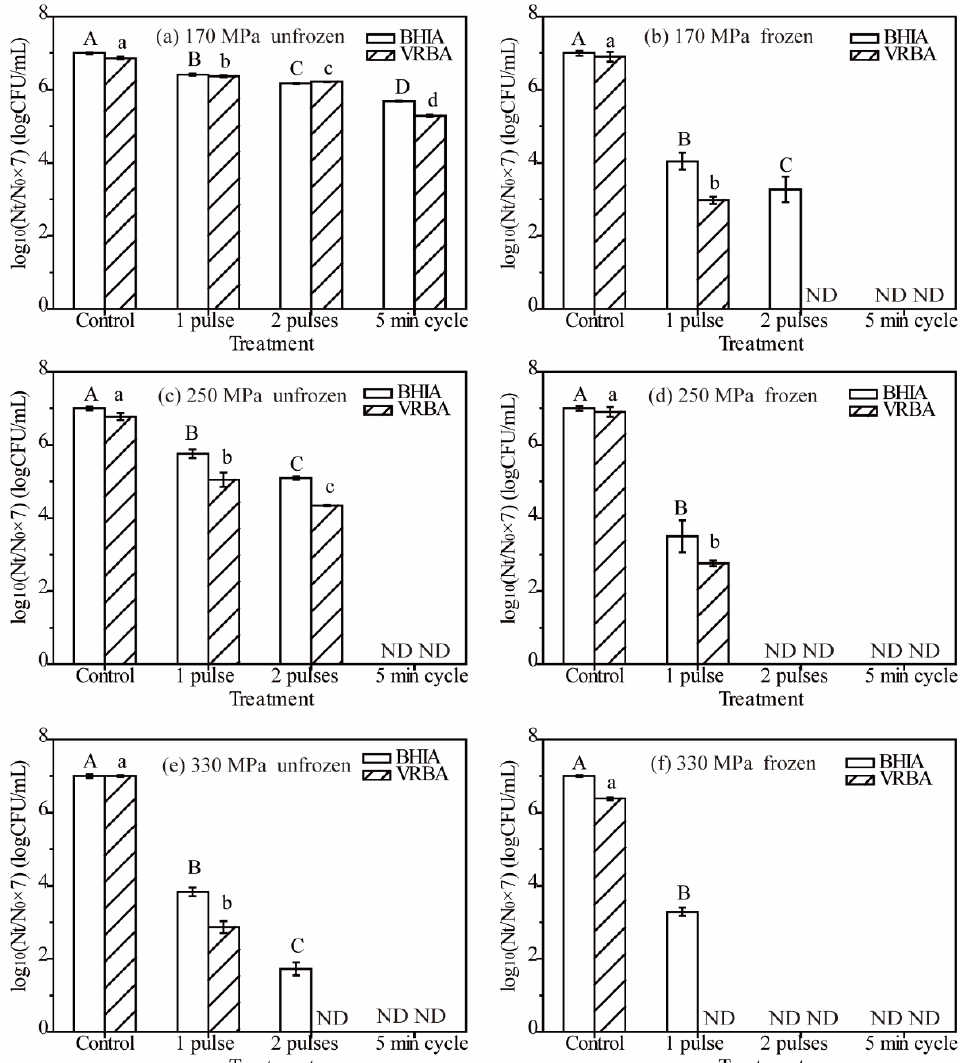
Figure 3. The E. coli survivors in unfrozen and frozen Chinese bayberry juice after different HP treatments (170 MPa (( a ) unfrozen, ( b ) frozen), 250 MPa (( c ) unfrozen, ( d ) frozen), 330 MPa (( e ) unfrozen, ( f ) frozen)) on BHIA and VRBA. Different letters (A, B, C, and D or a, b, c, and d) indicate a significant difference ( p < 0.05) (when the same letter shares—not significant p > 0.05) between treatments on the same enumeration medium. ND means not detected. Mean values ± standard error ( n = 3).